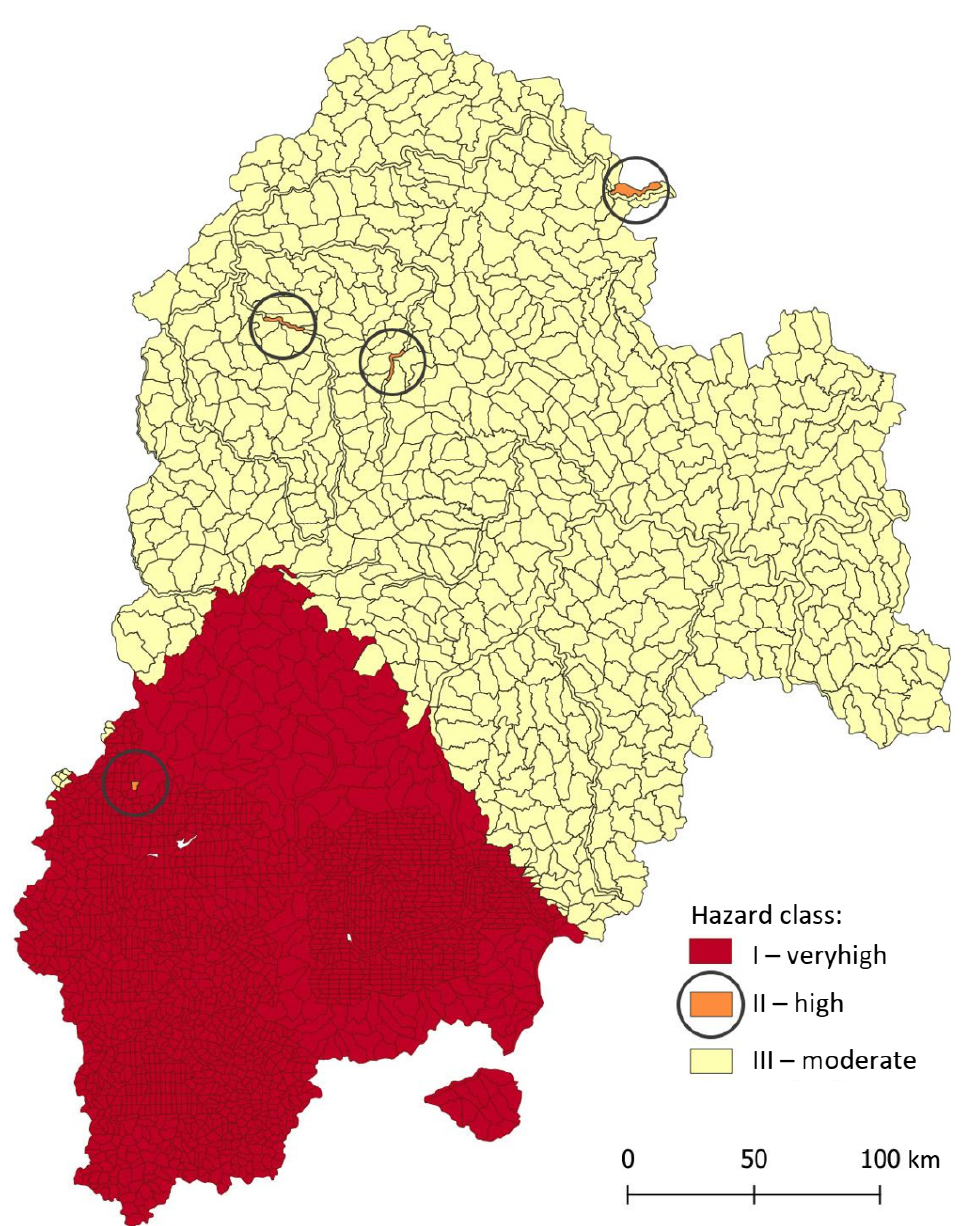
Figure 12. The forecasting results in the Bodaibinsk forestry.